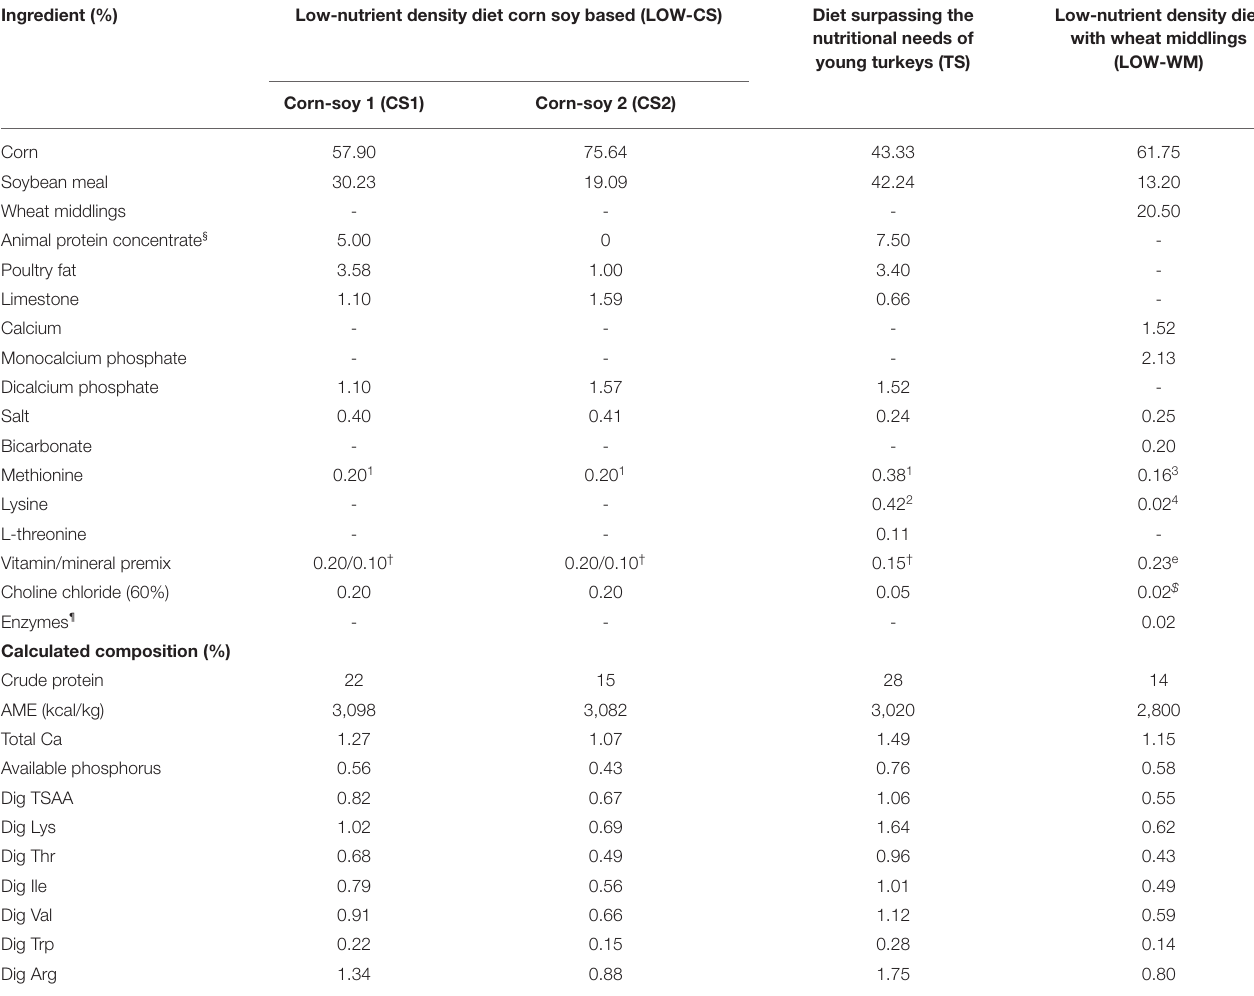
TABLE 1 | Composition of the experimental diets. Ingredient (%) Low-nutrient density diet corn soy based